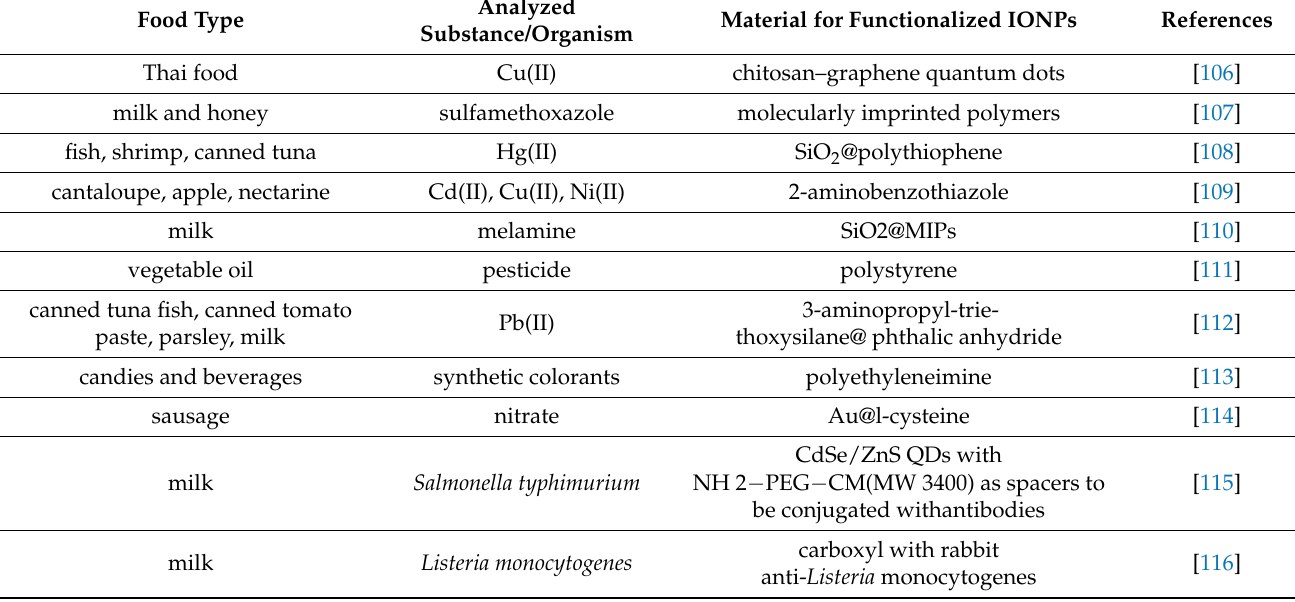
Table 5. Examples of the use of IONPs in food